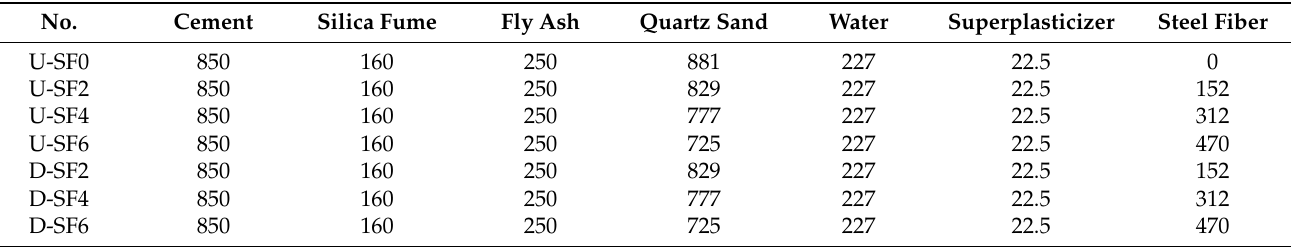
Table 2. Mix proportion of fiber-reinforced UHPC (kg/m 3